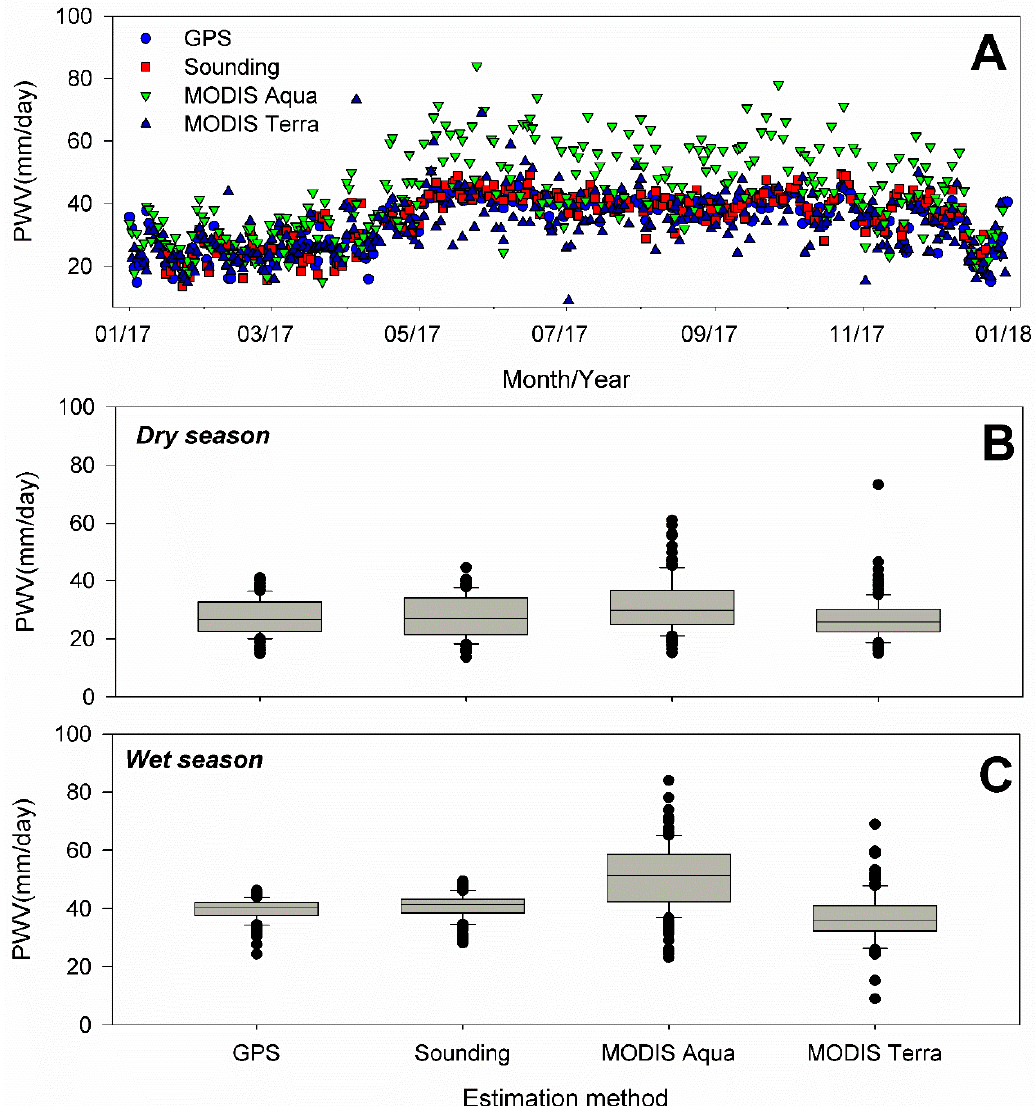
Figure 6. ( A ) The time series of PWV (mm / day) estimated for AACR using GPS (blue circles), atmospheric sounding (red squares), MODIS Aqua (green inverted triangles), and MODIS Terra (blue triangles). ( B , C ) Box plots of the PWV (mm / day) estimated using GPS, atmospheric sounding, MODIS Aqua, and MODIS Terra for the dry season and wet season in AACR, respectively: The grey box indicates the 25th and 75th percentiles with the median in middle. The error bars indicate the minimum and maximum values. The black circles indicate outliers (1.5 times the central box).